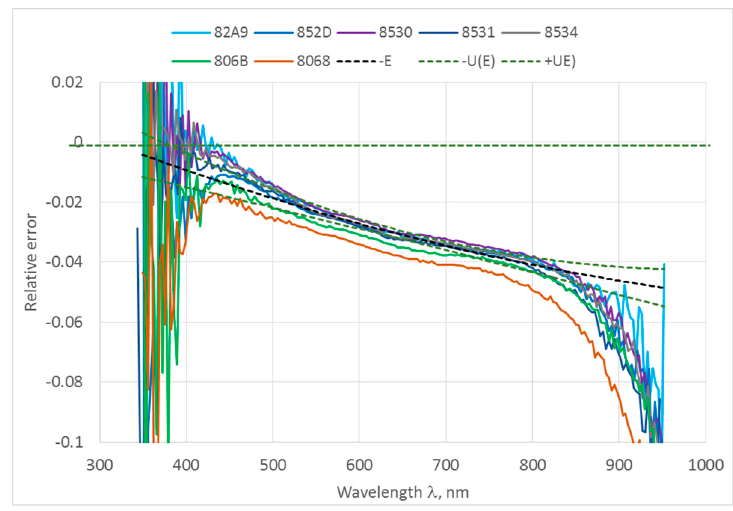
Figure 14. Non-linearity errors of different radiance sensors scaled to full-range value. Dashed lines are fitted model with uncertainty.